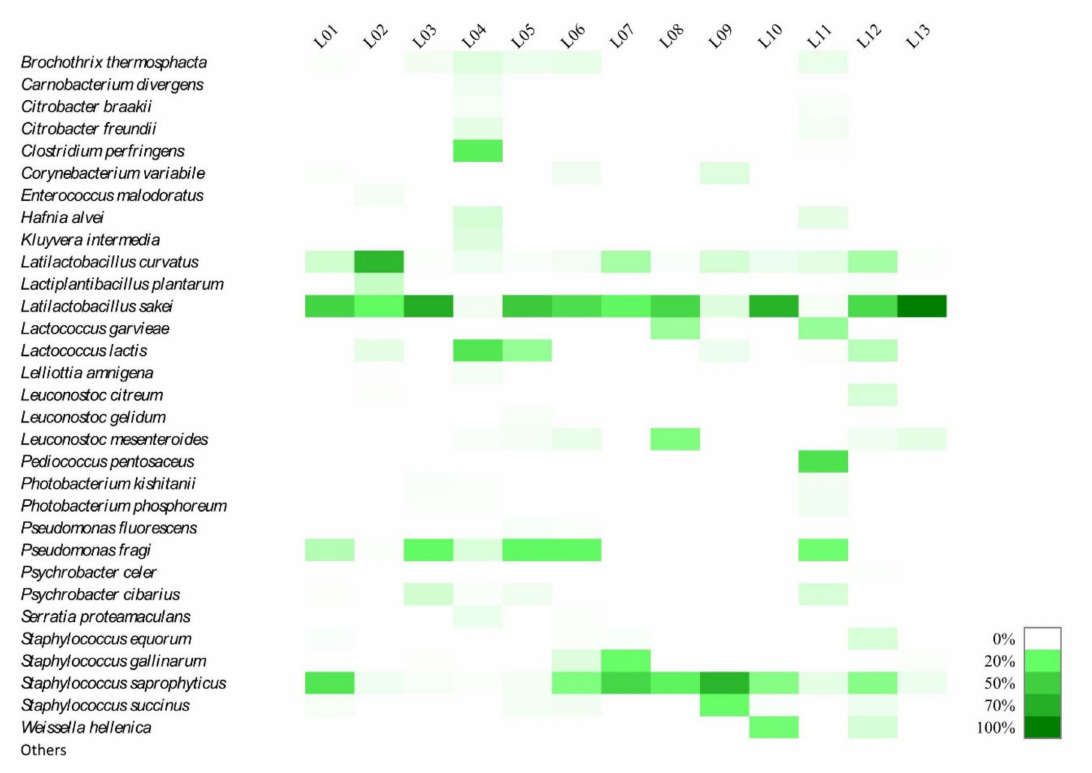
Figure 1. Relative abundance (%) of bacterial species in artisanal Colonial salami-type dry-fermented sausages. Species with a very small number of reads (relative abundance < 1%) were classified into the category